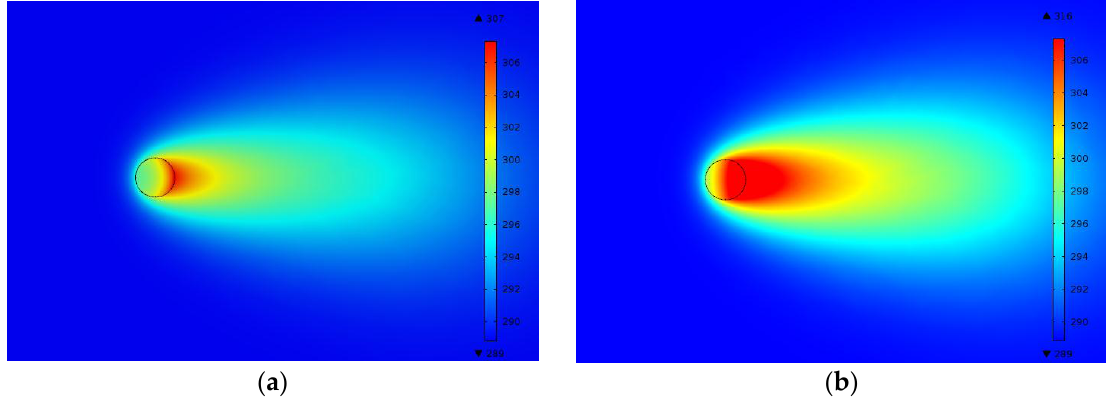
Figure 7. Temperature response after one-month (u = 2.5 × 10 −6 m/s, D/L ratio = 0.025). ( a ) Borehole permeability same as ground; ( b ) Impermeable borehole.